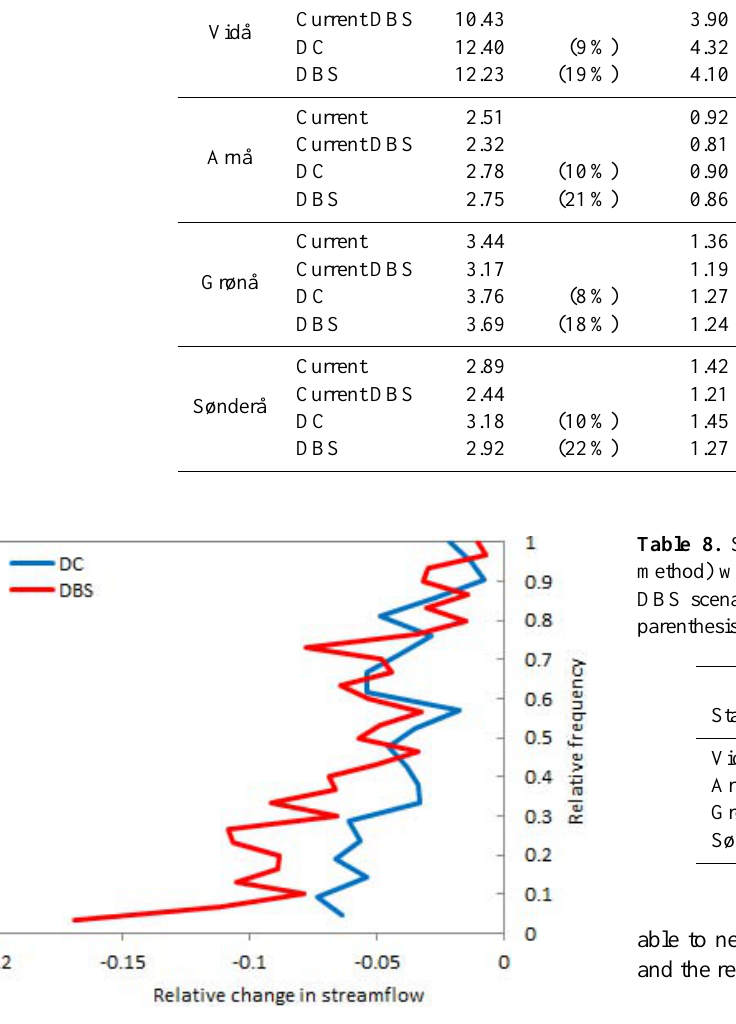
Fig. 11. Change in low stream flow due to irrigation using the DC method and the DBS method.